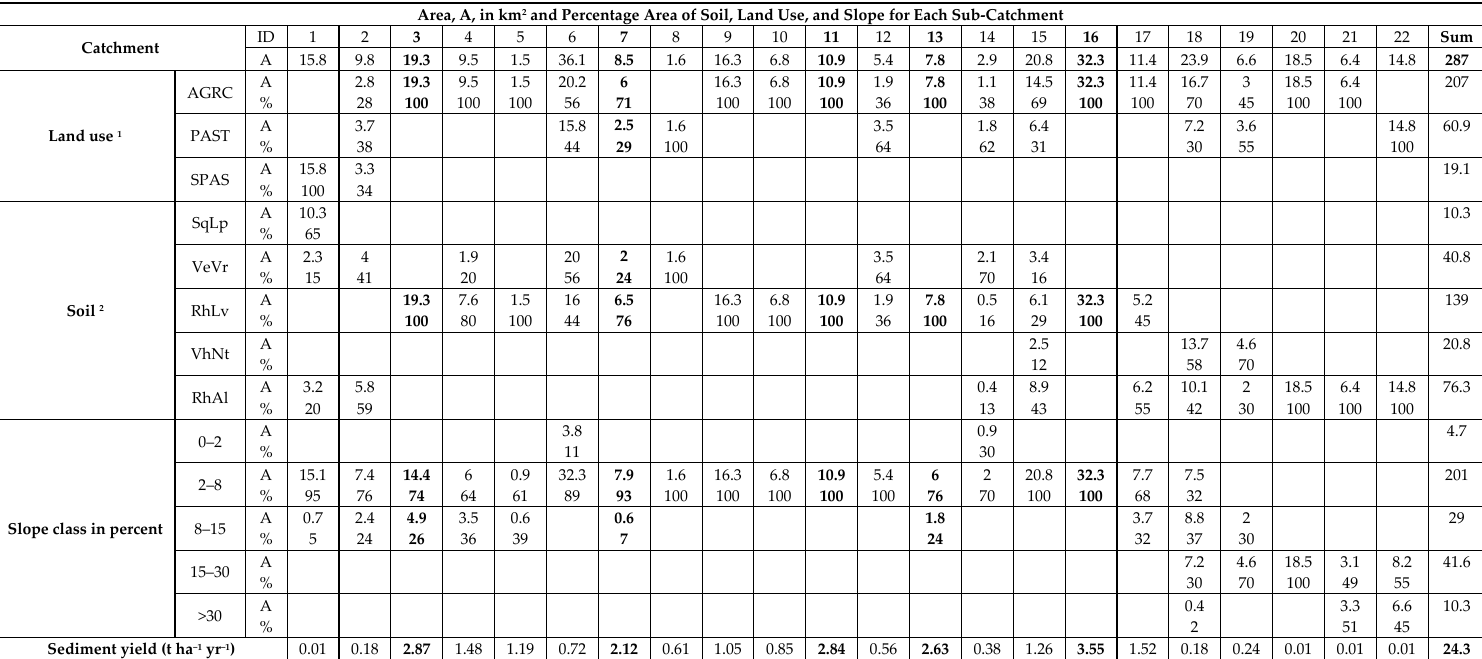
Table 7. Effect of the spatial distribution of soil and land use on soil erosion.